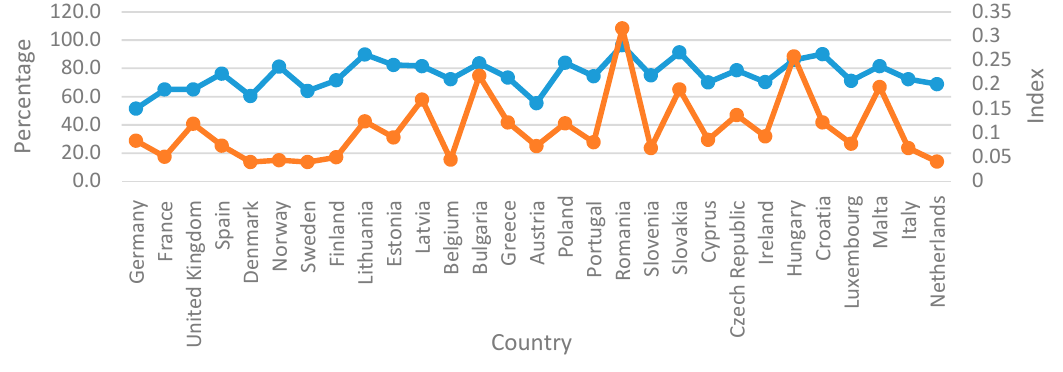
Figure 7. Correlation between the population distribution by the income group, type of household and tenure status, and the gender inequality index of the 25 EU countries, the UK and Norway under evaluation (data for 2018).